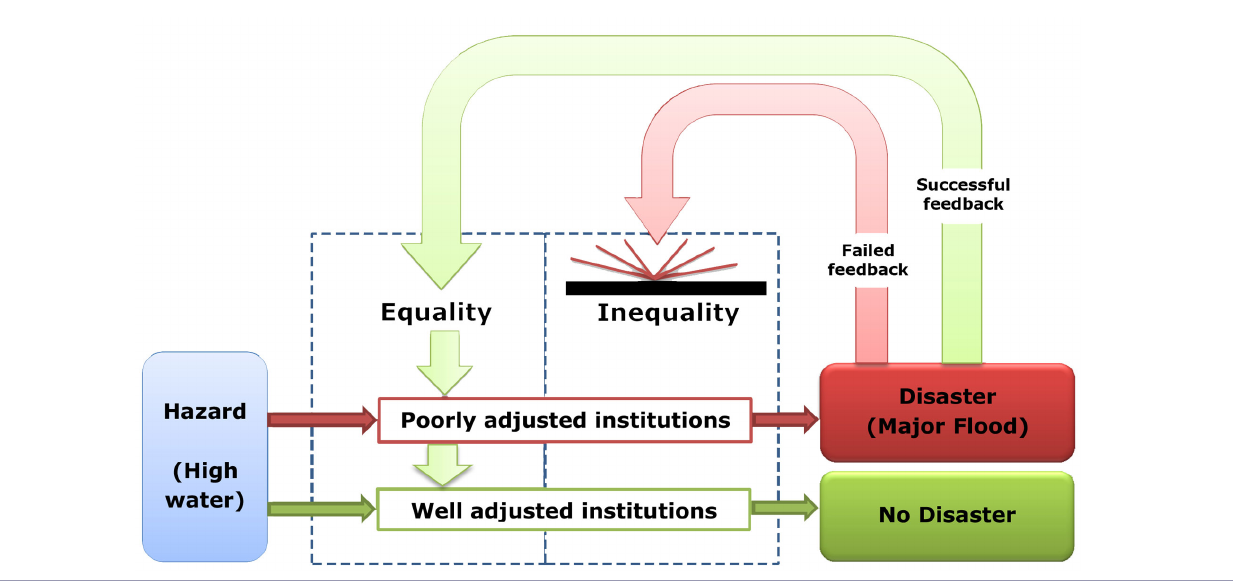
Fig. 6 . Analytical framework that links the exogenous hazard of water surges to institutions embedded in their socio-political context (with levels of equality as a main characteristic) and outcomes (flood disaster or not), with a suggested feedback loop leading back to institutions (adaptation or